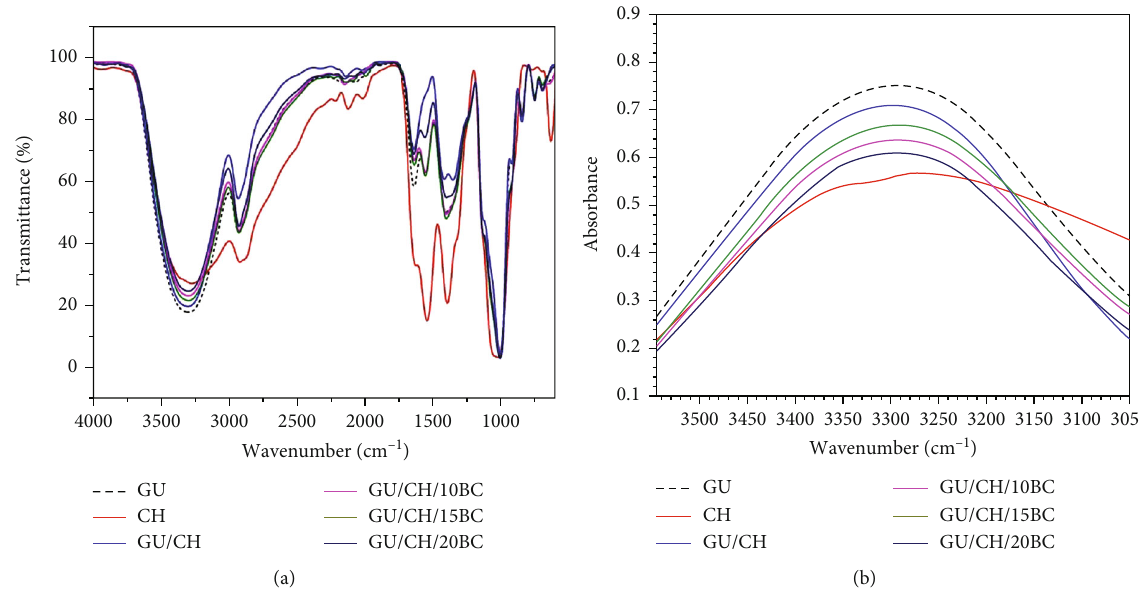
Figure 5: FTIR spectrum resulting from triplicate measurements of each fi lm. The full spectrum from 4000 to 250cm -1 (a). Sections of the spectrum for O-H stretching vibration